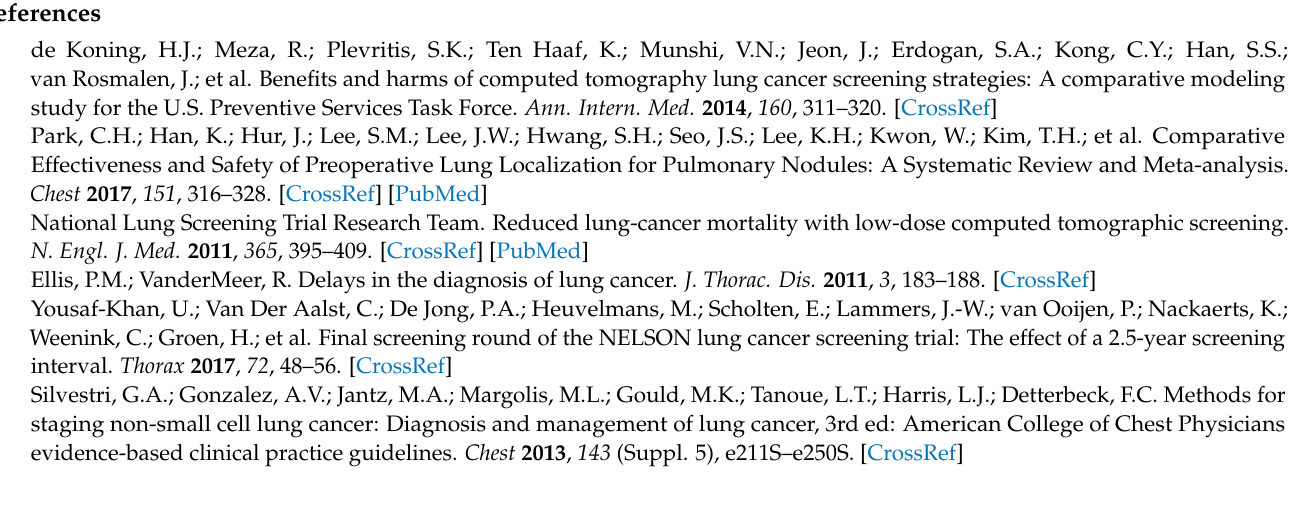
Figure S2. Flexible bronchoscopes, Figure S3. Virtual navigation images on LungPoint system, Figure S4. The Electromagnetic navigation image of superDimensionTM System, Figure S5. The Cone-beam computed tomography, Figure S6. The image of augmented